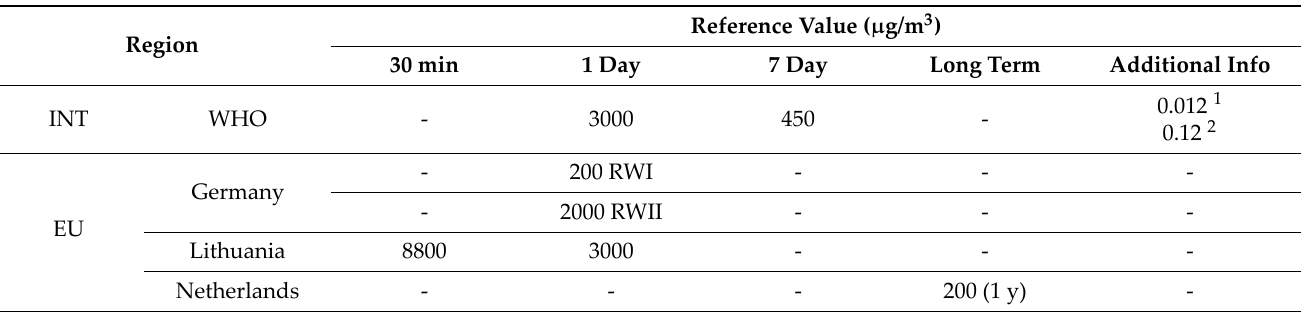
Table 8. Reference values for dichloromethane.